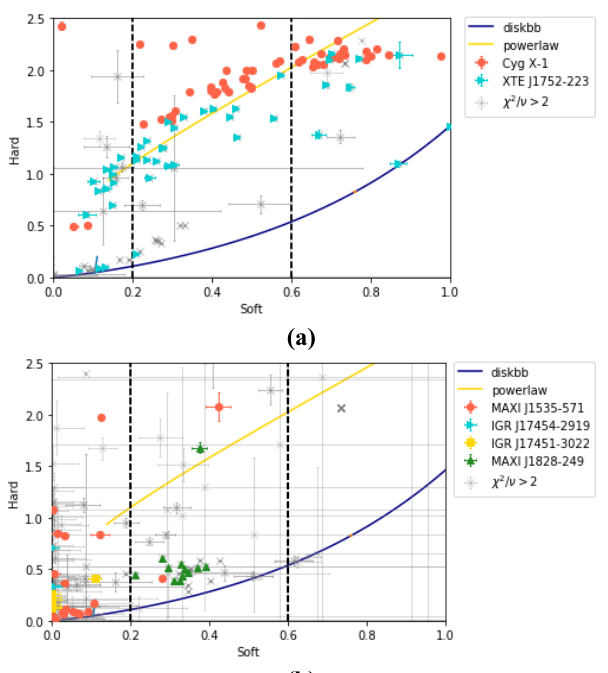
Fig. 5. Color-color diagram of Cyg X-1 and XTE J1752-223 (a) and all candidates (b). The dashed black lines are soft color which correspond to 0.7 – 1.5 keV of the disk innermost